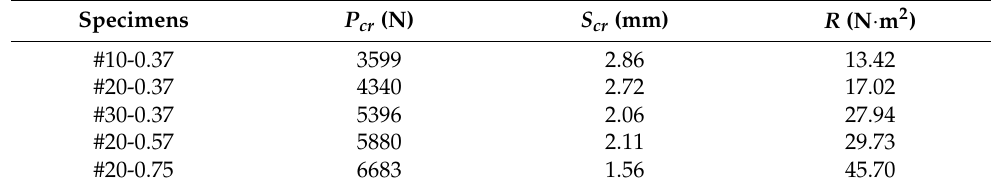
Table 2. Peak load ( P cr ), displacement at peak load ( S cr ) and bending stiffness ( R ) of specimens.